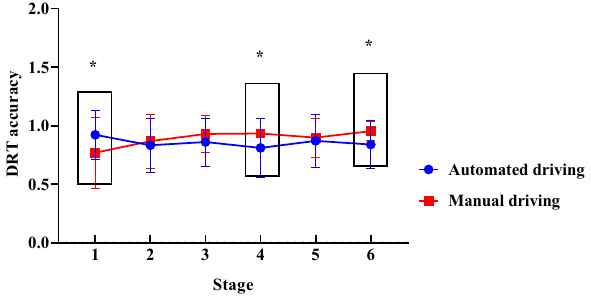
Figure 4. The influence of driving mode on the DRT accuracy in the six stages (Note: * p < 0.05).